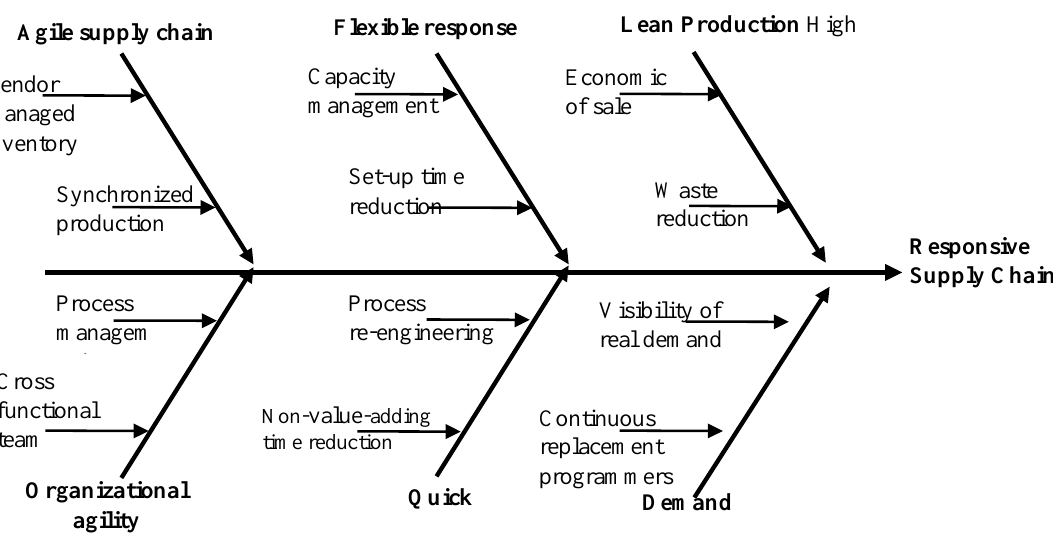
Fig. 5. Strategy of responsive supply